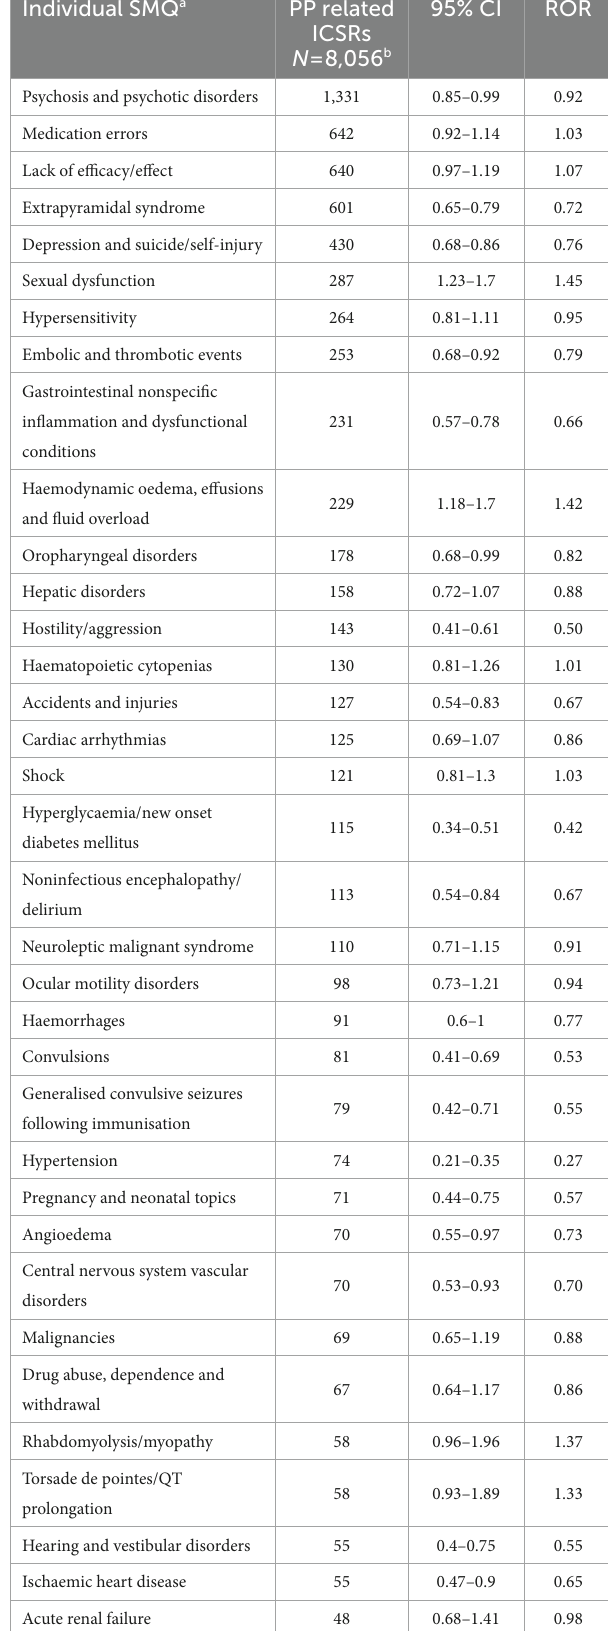
TABLE 3 Relative ADRs frequencies observed in PP3M-related ICSRs formulations as compared to PP1M-related ICSRs, stratified by system organ class.